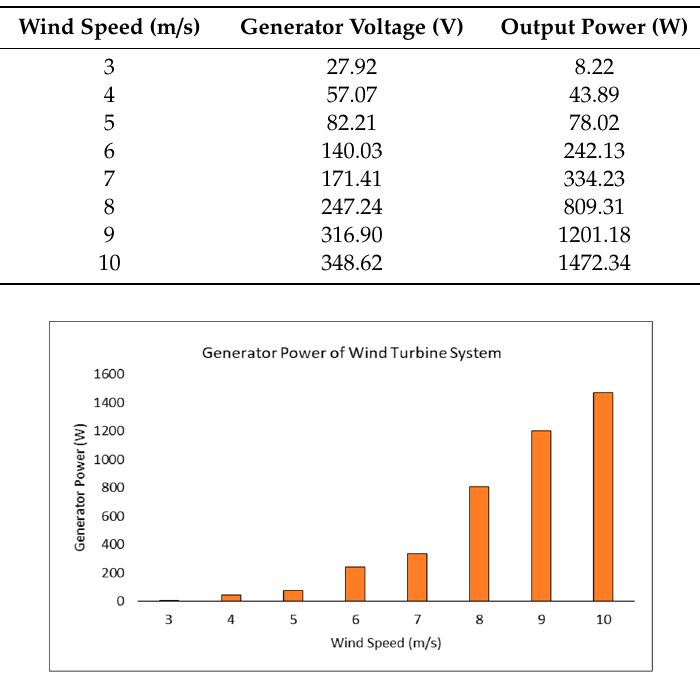
Figure 11. Generator output power of wind-turbine system. Table 7. Results of the PO algorithm sensitivity test.